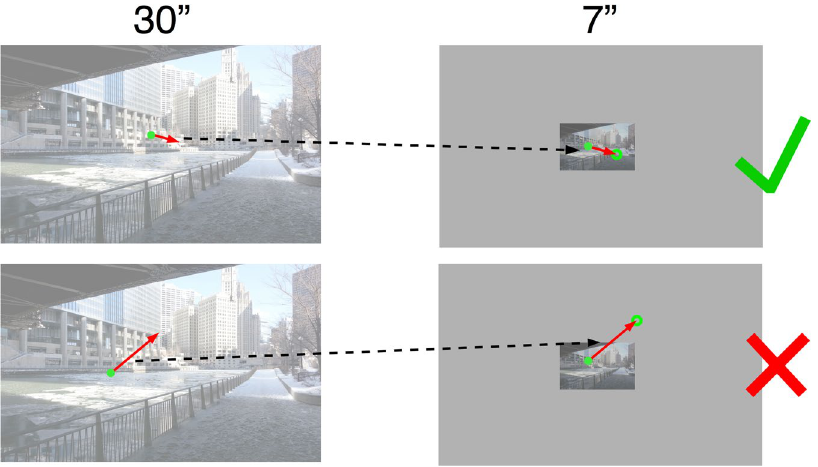
Figure 6. Graphical illustration of the sampling strategy applied to create the simulated distribution of saccade amplitudes of 7” images. Amplitude and angular direction of a randomly chosen saccade made on a 30” image was applied on a randomly selected fixation made on a 7” image. When the target of the corresponding saccade fell into the image coordinates of the 7” image, the saccade was “accepted” for the simulated distribution of saccade amplitudes (upper row). When the target position of the saccade was outside the image coordinates of the 7” image, the saccade was “rejected” (lower